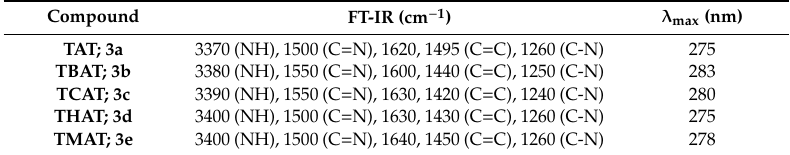
Table 1. FTIR (cm − 1 ) and Ultra-Violet and Visible (UV)-Visible ( λ max nm) data for compounds 3a – e .